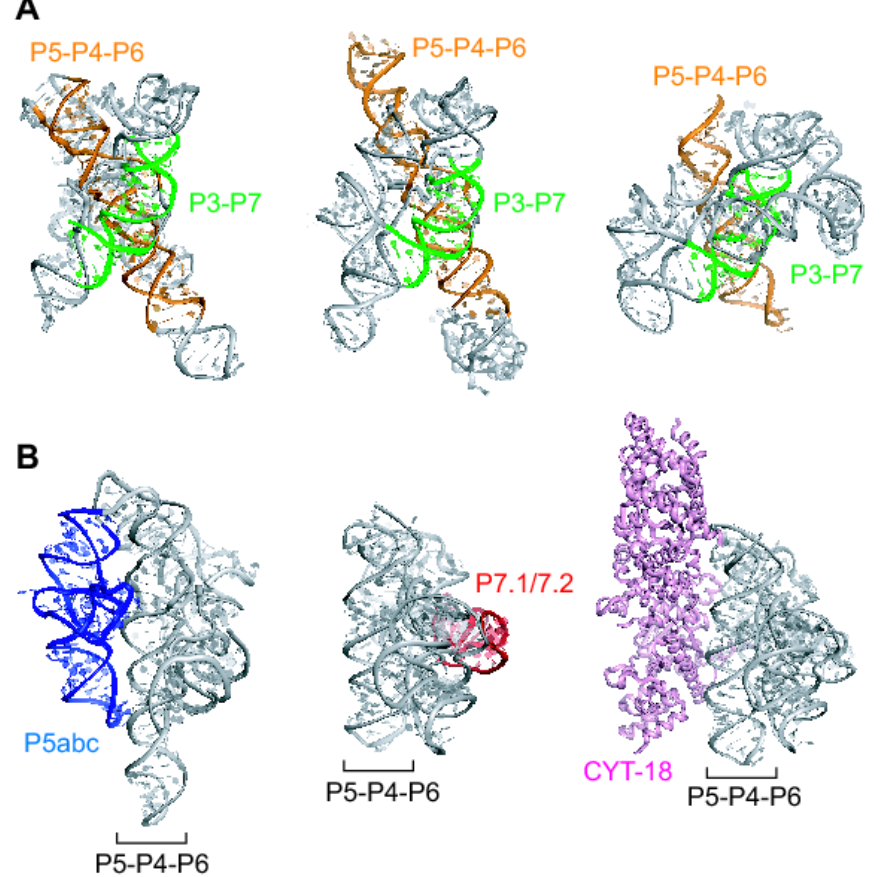
Figure 1. The modular architecture of naturally occurring group I ribozymes. (A) Conserved core elements of group I ribozymes. P3-P7 (green) and P5-P4-P6 (orange) are helical domains universally conserved in group I ribozymes. Crystal structures of group I ribozymes from Tetrahymena (left), Azoarcus (center), and Twort (right). (B) Peripheral RNA elements and a trans -acting protein factor of group I ribozymes. The P5abc subdomain of the Tetrahymena ribozyme (left, blue) and the P7.1/7.2 subdomain of the Twort ribozyme (center, red) stabilize the 3D structures of the conserved core consisting of P3-P7 and P5-P4-P6. The CYT-18 protein (right, pink) is able to stabilize the conserved core of diverse group I ribozymes lacking the P5abc subdomain. In the Tetrahymena group I ribozyme, the CYT-18 protein can functionally replace the P5abc